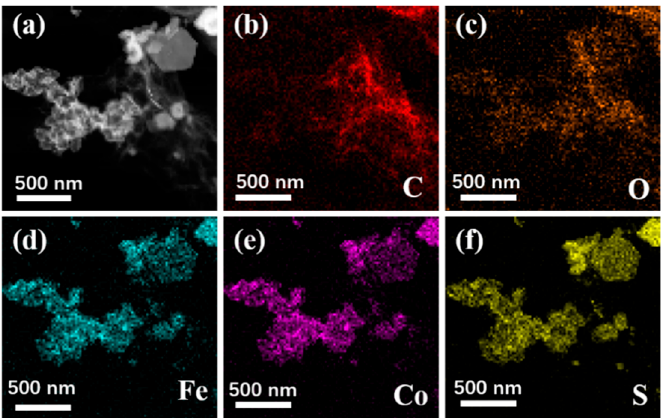
Figure 5. TEM of CoS@Fe 3 O 4 @rGO ( a ) and its corresponding elemental mapping images of C ( b ), O ( c ), Fe ( d ), Co ( e ), and S ( f ).